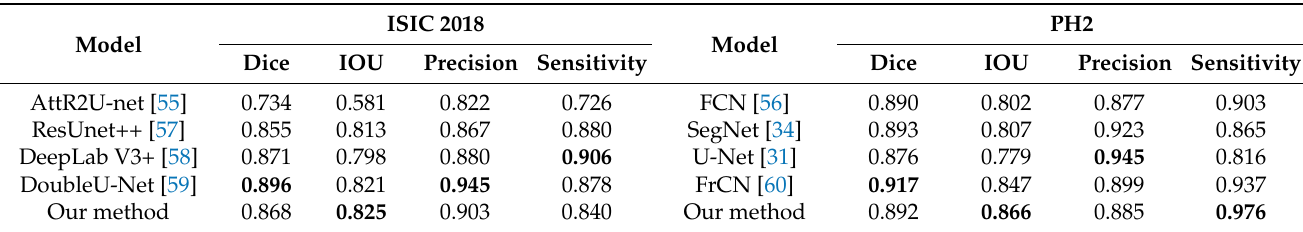
Table 2. A comparison between our method (approach with best results) and the state of the art on the same